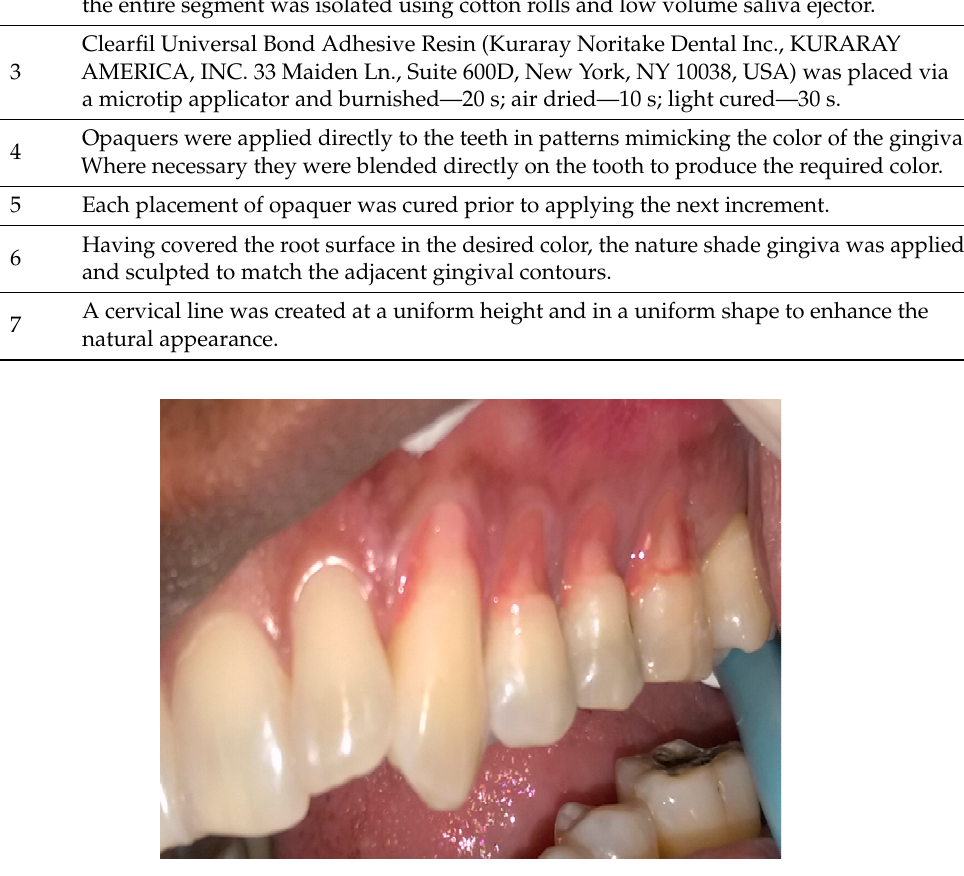
Figure 2. Initial placement of the dark opaque.